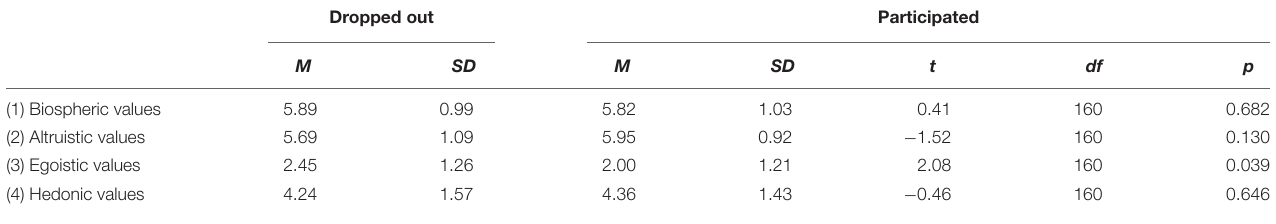
TABLE A1 | Comparison between people with missing answers on all social change action items (dropped out) and those with filled-in answers